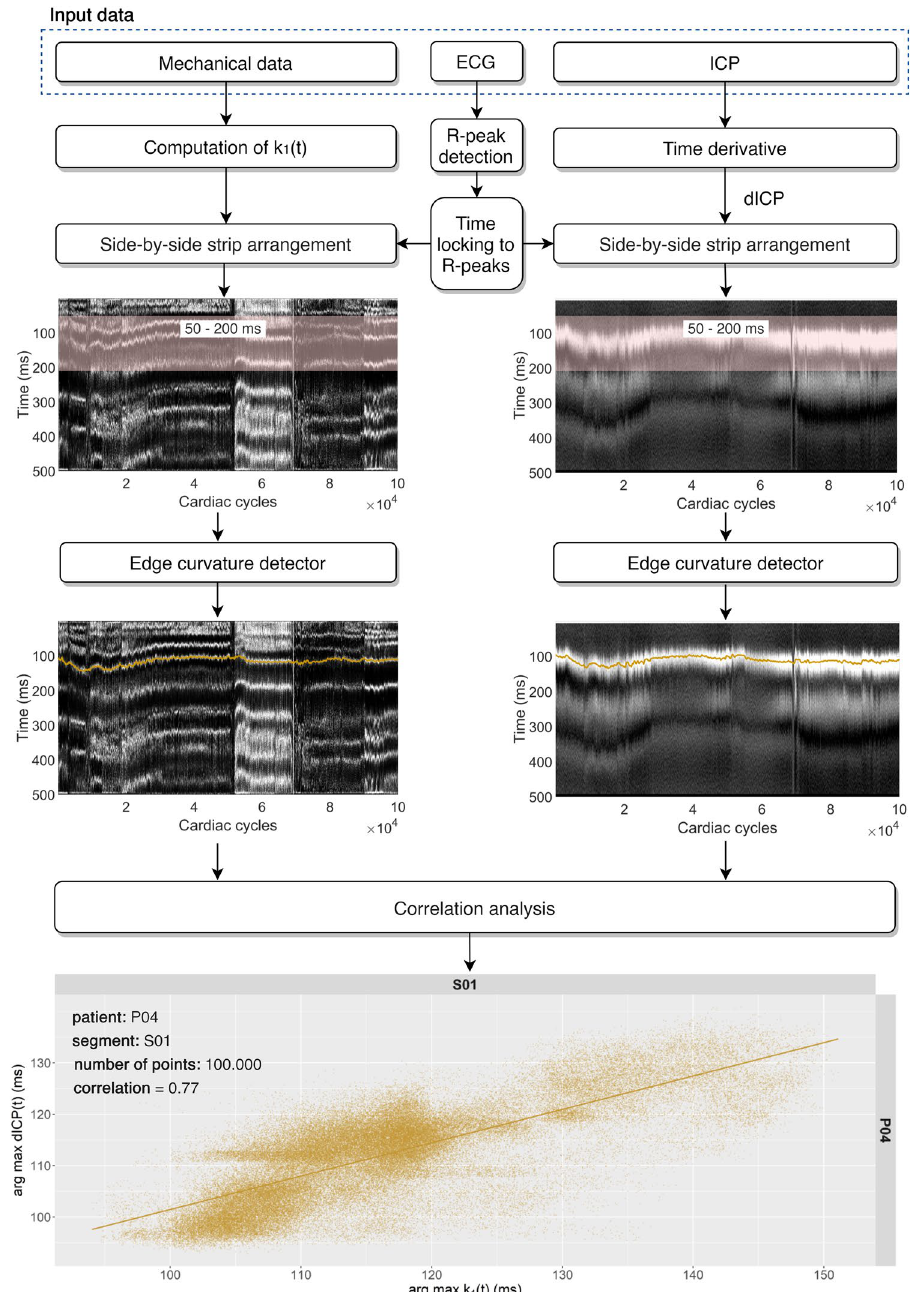
Figure 3. Block diagram of the signal processing methodology. These data refer to the patient P04 and the segment S01. The total number of points in the correlation plot (EIs) is 100,000; the Pearson’s correlation coefficient between the detected edge curvatures (orange lines) is 0.77. The plots were generated using Matlab2020a (Cartan maps, https:// www. mathw orks. com/), R 4.0.0 (R Core Team (2020). R: A language and environment for statistical computing. R Foundation for Statistical Computing, Vienna, Austria. URL https:// www.R- proje ct. org/.) with ggplot2 3.3.2 (H. Wickham. ggplot2: Elegant Graphics for Data Analysis. Springer- Verlag New York, 2016.) and the figure was assembled using diagrams.net on-line tool (https:// www. diagr ams.